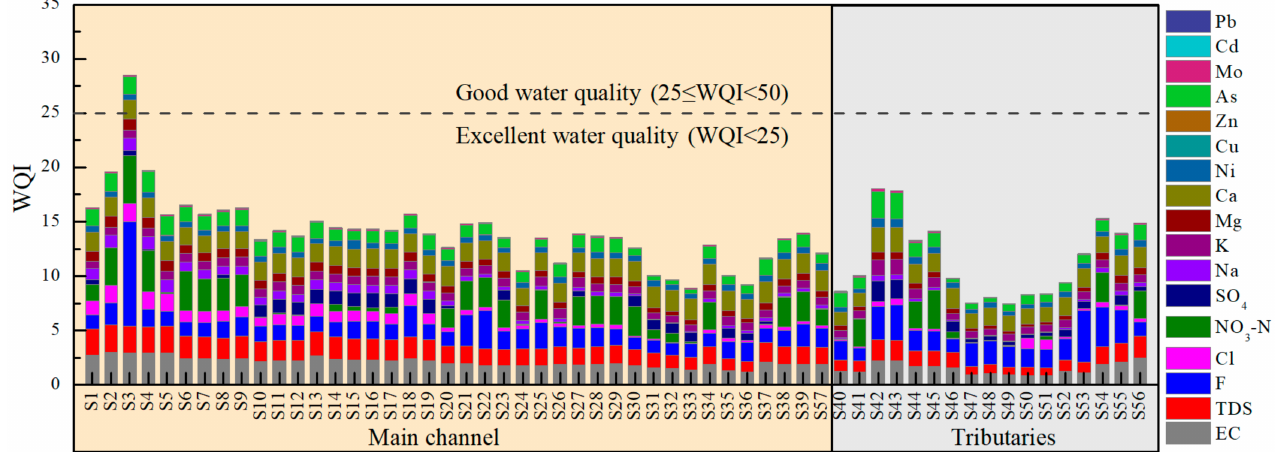
Figure 5. The spatial variations in the WQI along the main channel and tributaries of the upper TGR area.